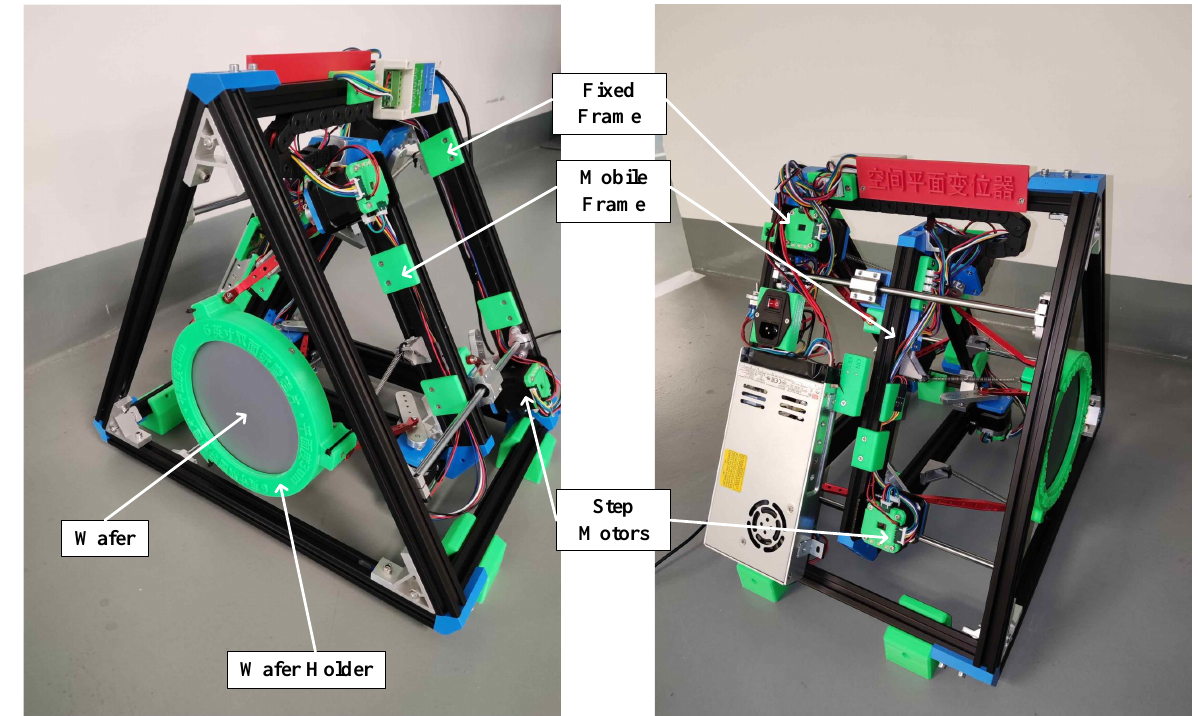
Figure 13. The electric motor-driven platform for plate attitude transformation.